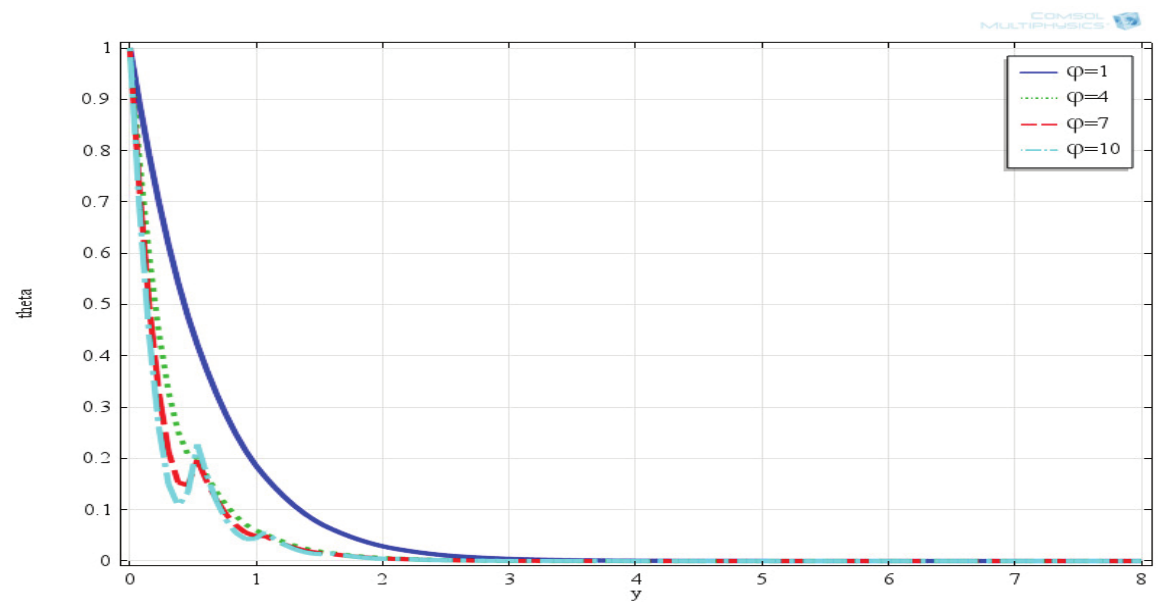
Figure 12: Steady state temperature profiles for different values of ϕ at